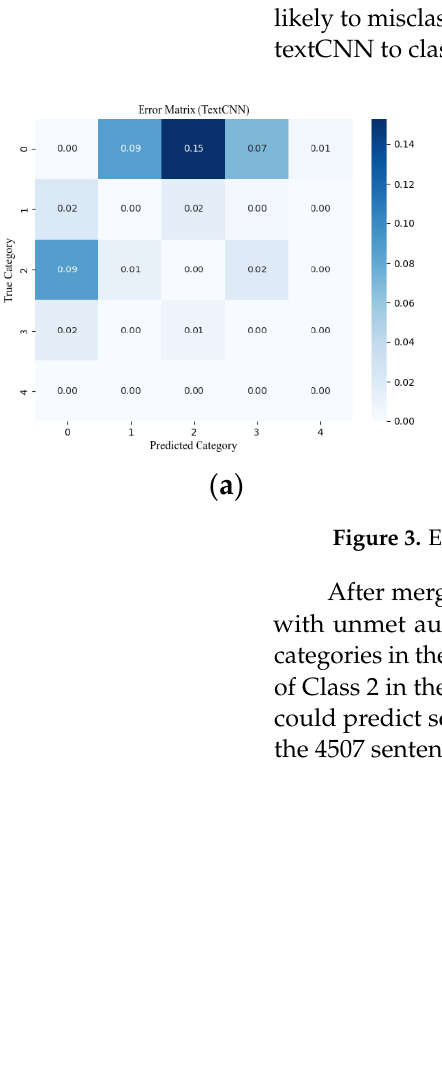
Table 4. Classifier performance of textCNN and XGBoost.